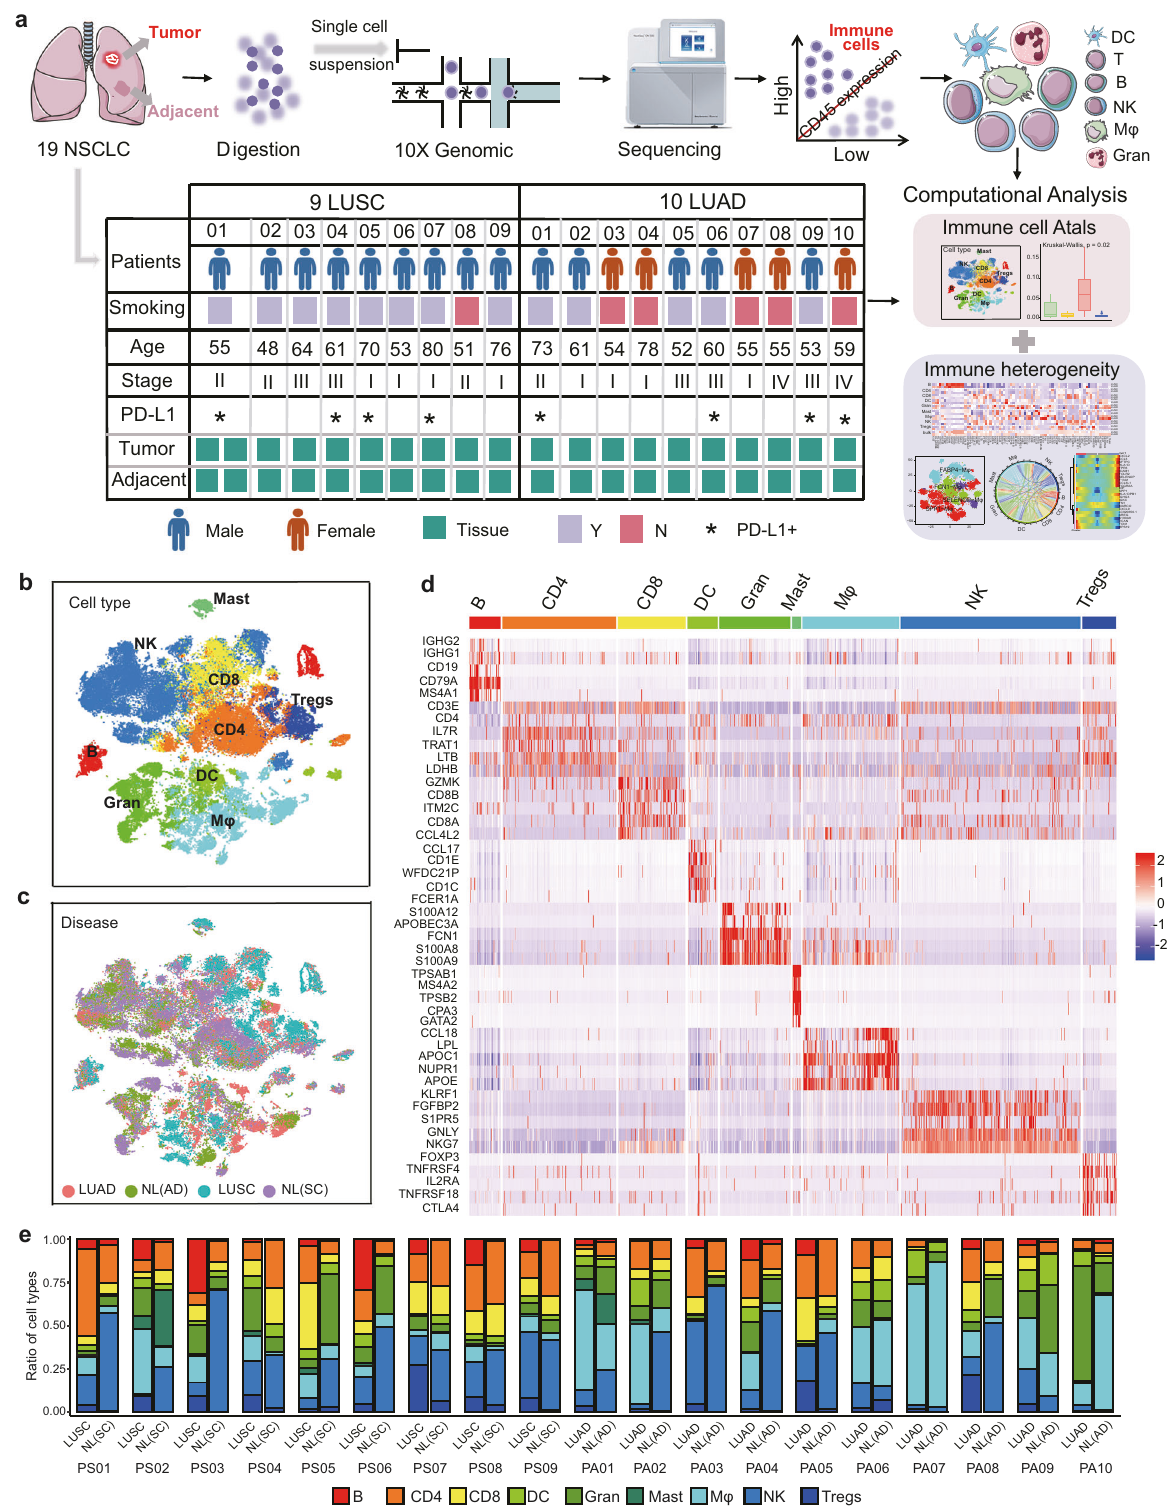
Fig. 1 High-resolution immune cell-type landscape of LUAD and LUSC samples in both tumor and corresponding normal tissues. a Schematic diagram highlighting the work fl ow of the study design and analysis. b t-SNE plot showing the identi fi ed cell types of all immune cells. c t-SNE plot of 72,475 single immune cells, colored by disease subtypes. d The heatmap showing the expression of cell type-speci fi c marker genes in different immune cells. M φ (macrophages), DC (dendritic cells), B (B cells), CD8 (CD8 + T cells), Gran (granulocytes), Tregs (regulatory T cells), NK (natural killer cells), CD4 (CD4 + T cells), Mast (mast cells). e Fraction of cell types originating from each patient. NL: adjacent normal lung tissue; NL(AD): adjacent normal lung tissue of LUAD; NL(SC): adjacent normal lung tissue of